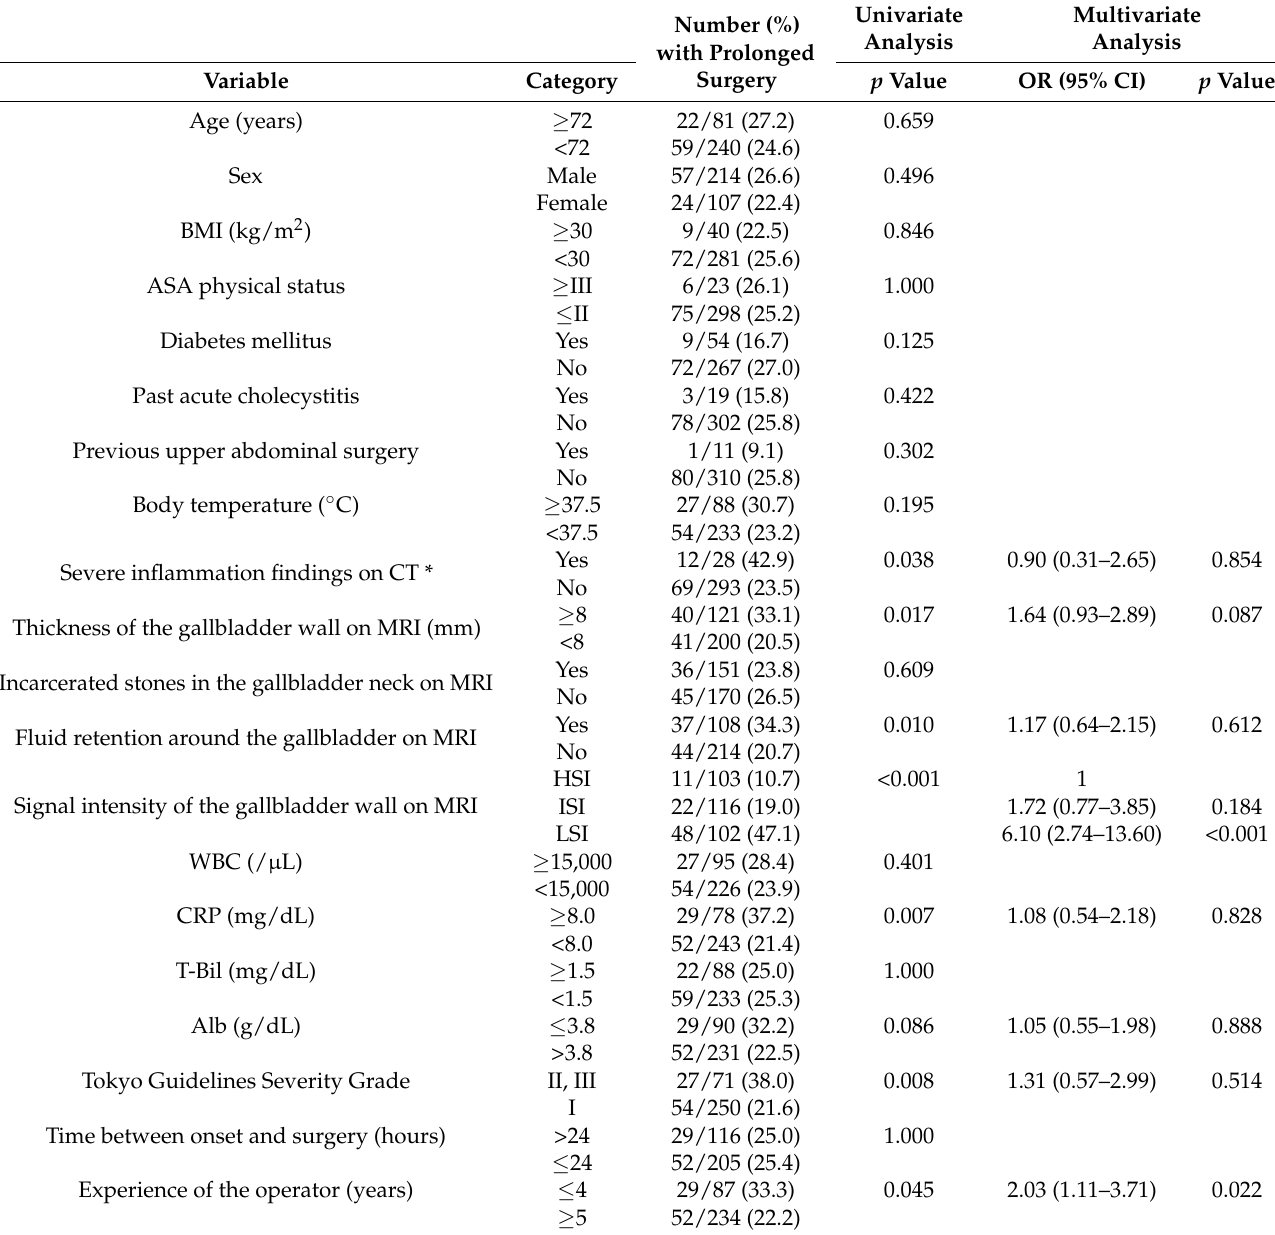
Table 4. Univariate and multivariate analyses of risk factors for prolonged surgery.